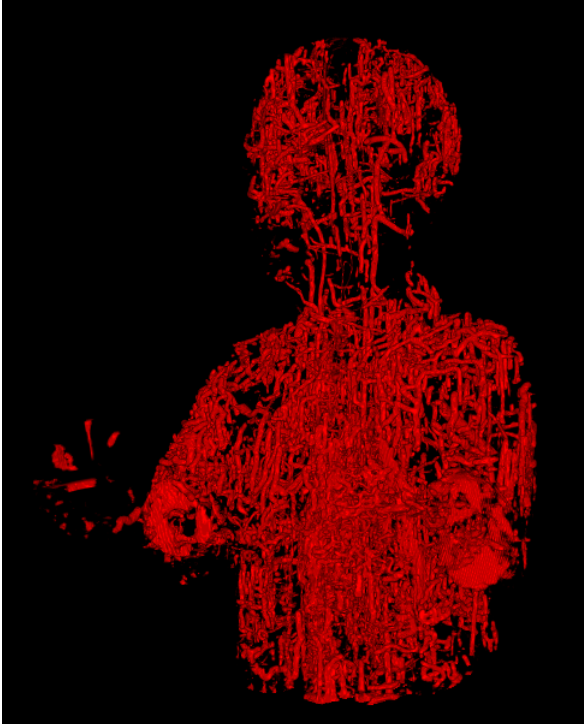
Figure 10: Wood worm holes in the upper body of the